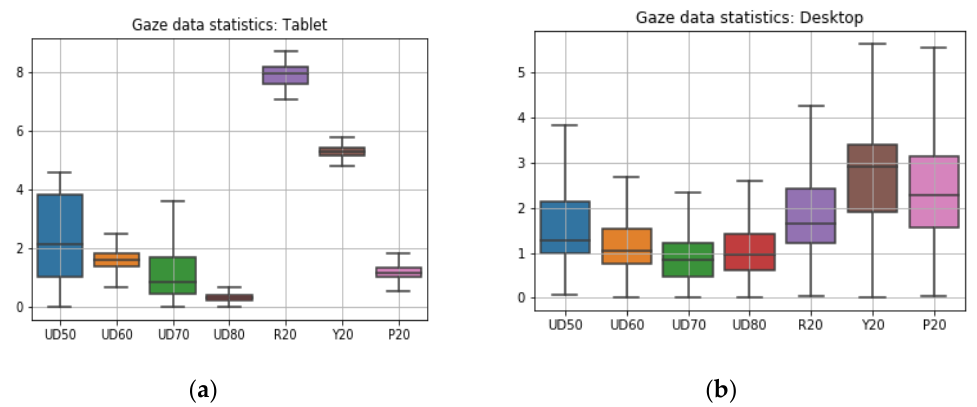
Figure 18. Gaze error statistics (box plots) from ( a ) desktop experiments and ( b ) tablet experiments. Y -axes of the plots represents gaze error in degrees. X -axis represents the different experiments from which data was used for plotting.